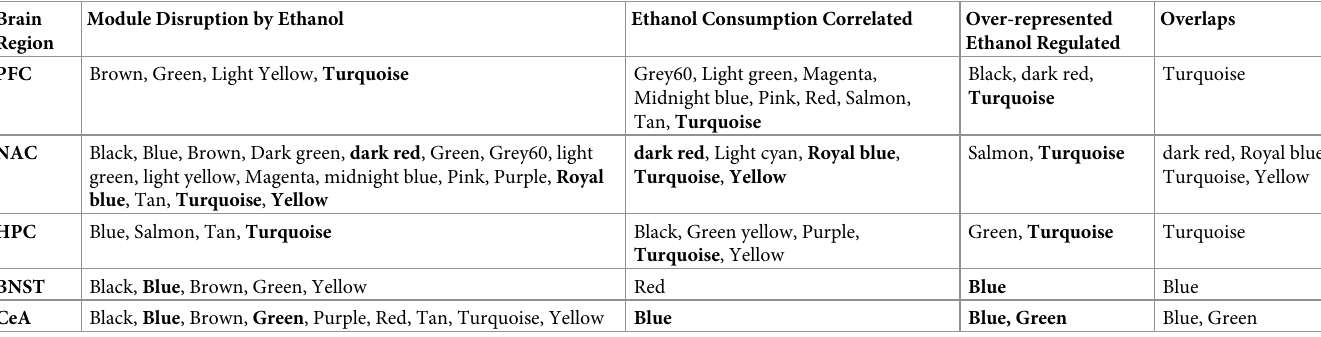
Table 3. Combined analysis of WGCNA module responses to ethanol. Brain Module Disruption by Region